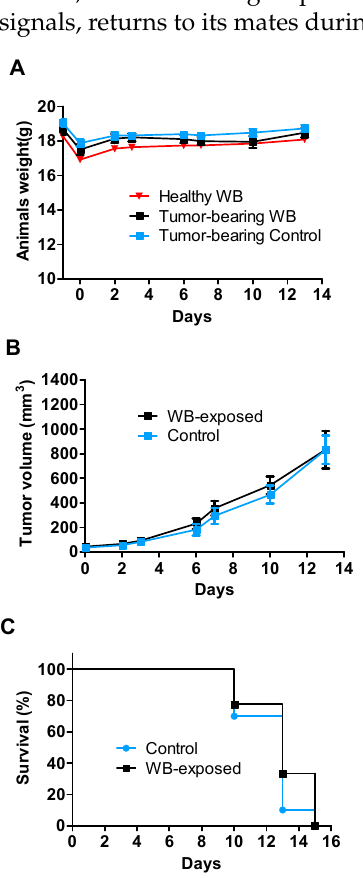
Figure 4. ( A ) Animal and ( B ) Tumor growth curves and ( C ) Tumor − bearing animals survival plot after animals’ exposure to wide − band signals generated by the DIEHL DS 110 wide − band (WB) signal generating system (N = 10 mice/group). Ad ( A ) Healthy animals were weighted two times on the day of HPEM exposure (D0): before and after arriving to the hangar, where field experiments were performed. Ad ( B ) Tumor − bearing animals were exposed 7 days following cancer cells inoculation and were sacrificed when the tumor volume was beyond the limit authorized by the ethics